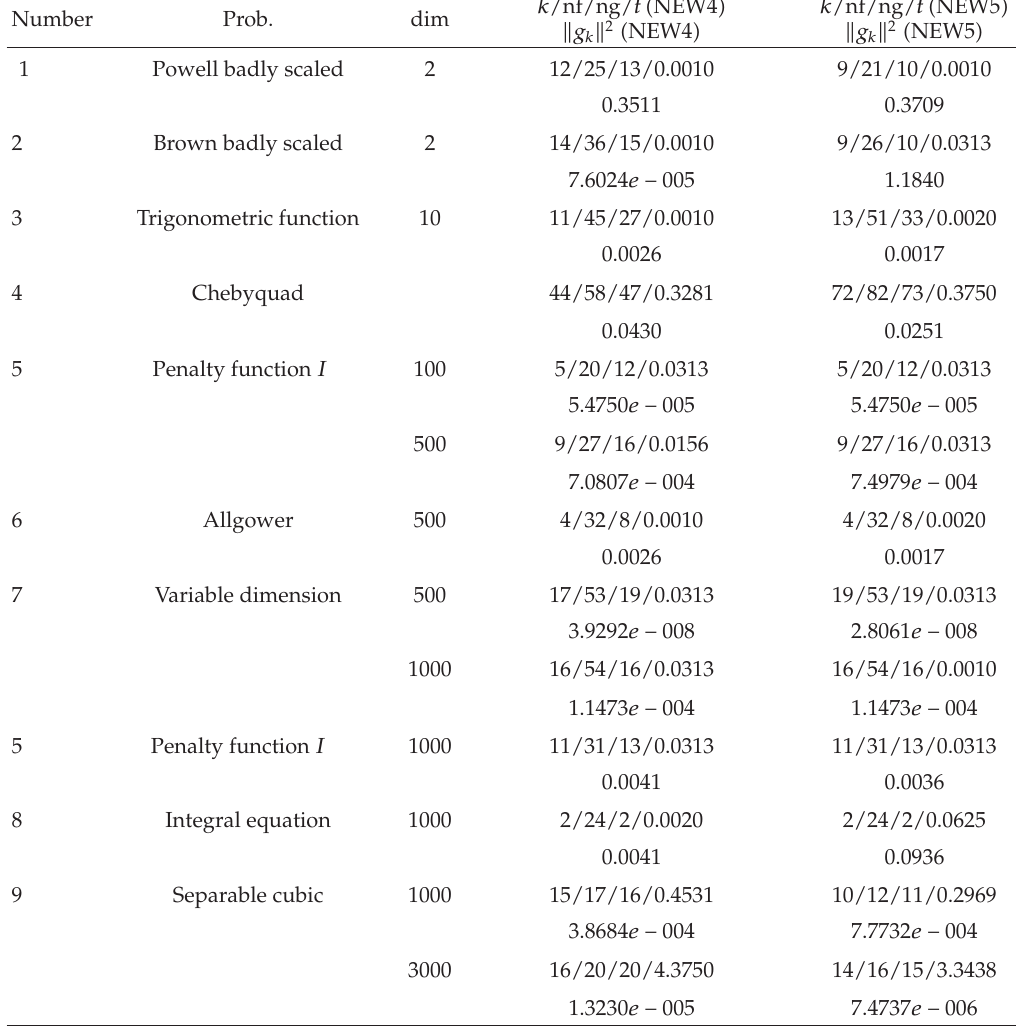
Table 3: Numerical results of the NEW4 and